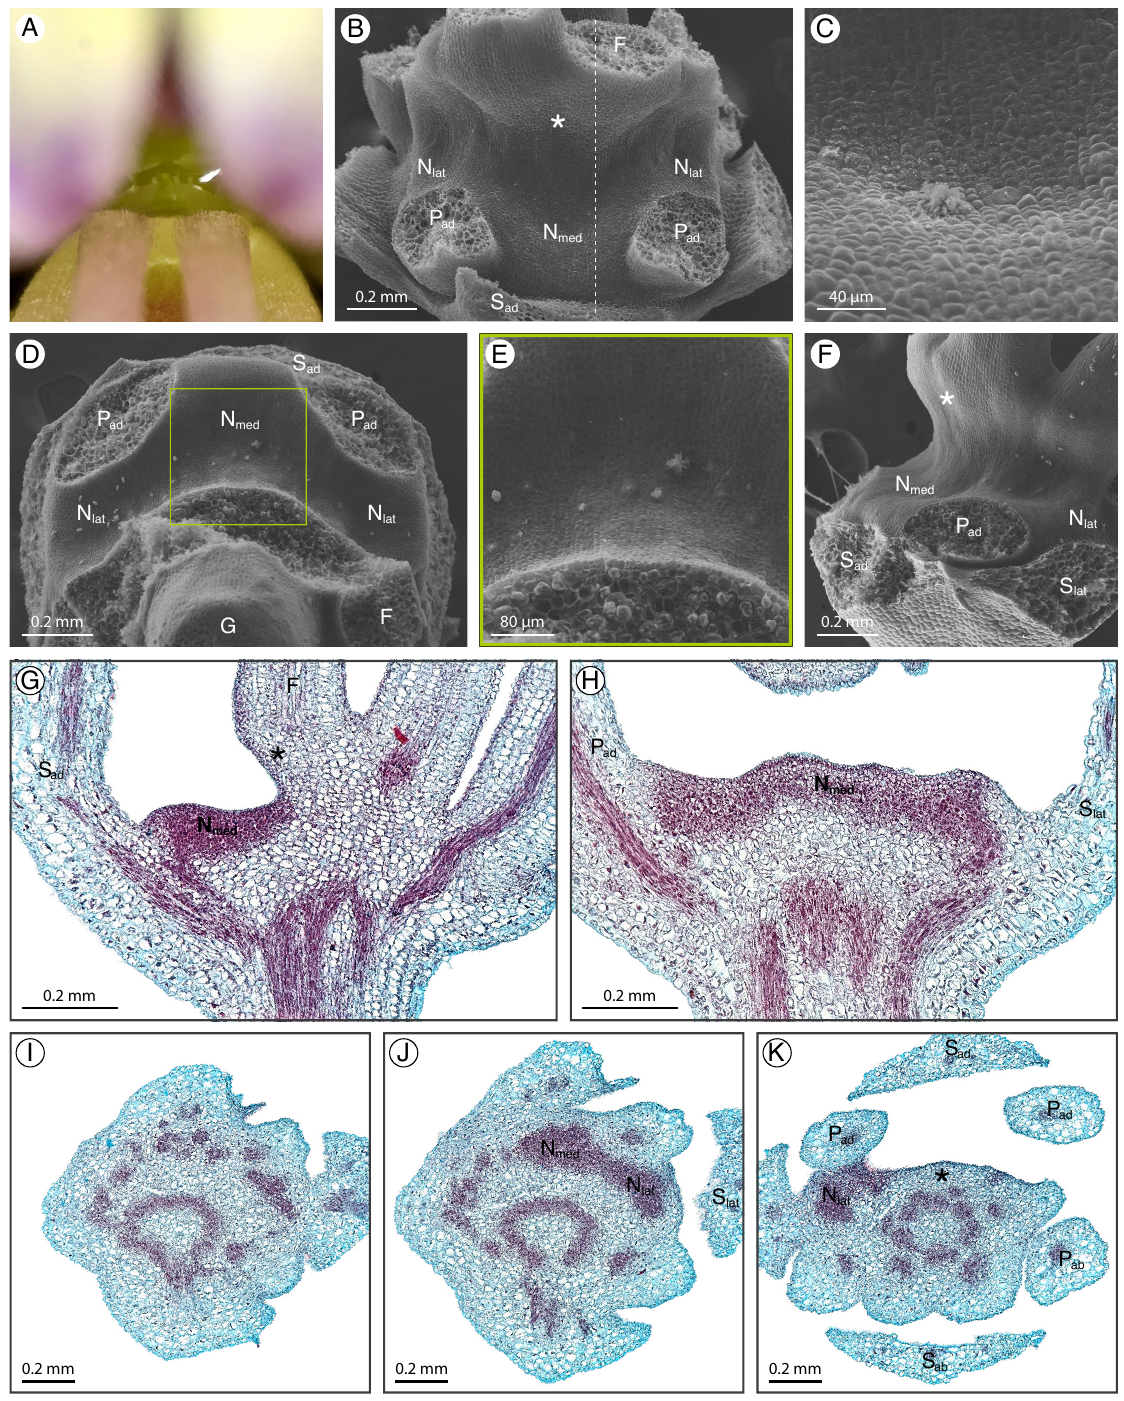
Figure 9. Sieruela rutidosperma nectary ( A ) photograph, ( B – F ) scanning electron micrographs, and ( G – K ) fast green and safranin O-stained sections. ( A ) Apical view of the nectary. ( B ) Adaxial view of the nectary. ( C ) Adaxial view close-up of the medial nectary lobe. ( D ) Apical view of the nectary. ( E ) Apical view close-up of the nectary, corresponding to the box in ( D ). ( F ) Lateral view of the nectary. ( G ) Longitudinal section (sagittal plane) of the intermediate stage nectary, corresponding to the dashed line in ( B ). ( H ) Longitudinal section (frontal plane) of the nectary. ( I – K ) Transverse section of the nectary from proximal to distal positioning. All images are of anthetic stage specimens unless indicated otherwise. Basal fusion of adaxial filaments is indicated with an asterisk. F: filament; G: gynophore; N lat : lateral nectary lobe; N med : medial nectary lobe; P ab : abaxial petal; P ad : adaxial petal; S ab : abaxial sepal; S ad : adaxial sepal; S lat : lateral